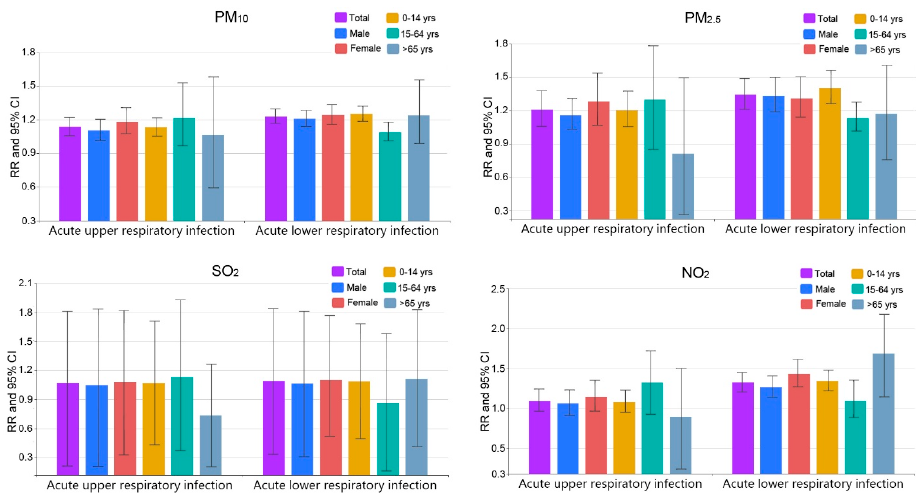
Figure 4. Relative Risks (RRs) and 95% confidence intervals (CIs) of acute respiratory infection hospital admissions in associations with 10 μ g/m 3 increases in air pollutant concentrations in Shenzhen, 2013.